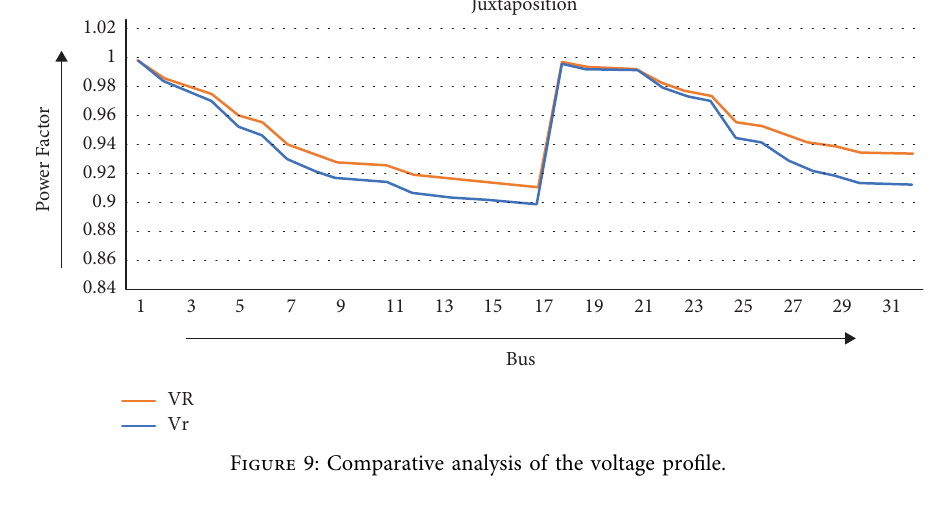
Figure 9: Comparative analysis of the voltage